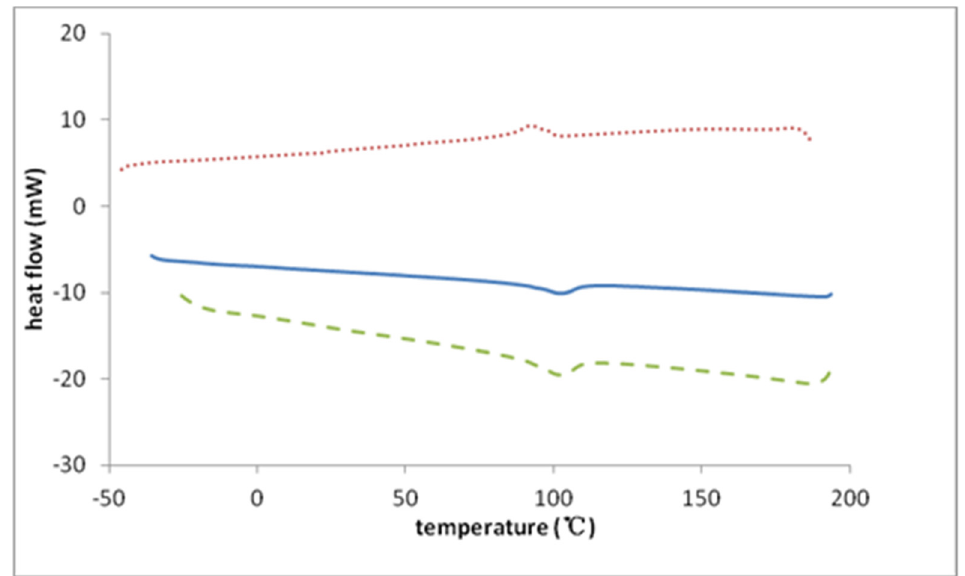
Figure 3. DSC scans for P23DM4VIm + Tf − : solid blue line (20 ° C/min—heating cycle), dotted red line (20 ° C/min—cooling cycle), dashed green line (40 ° C/min—rapid heating cycle). Endothermic heat flow is indicated by downward deflection from the baseline.